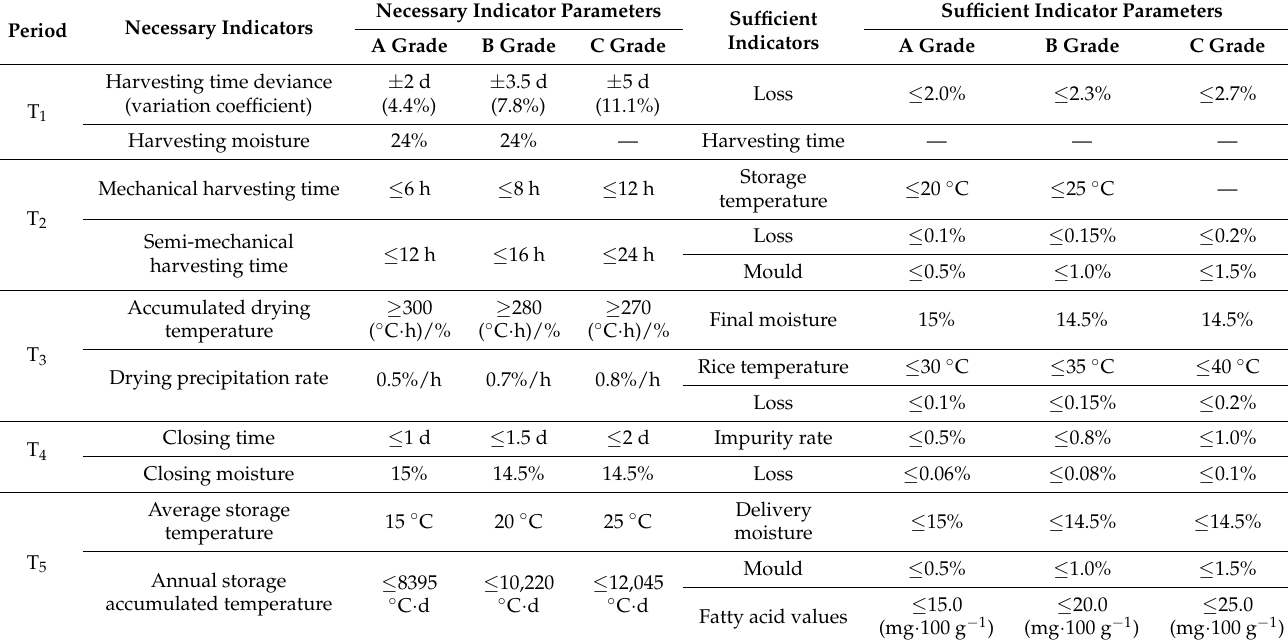
Table 1. Technical codes for 5T post-harvest management for high-quality rice (Source: Jilin DB22/T 3113–2020 [37]).